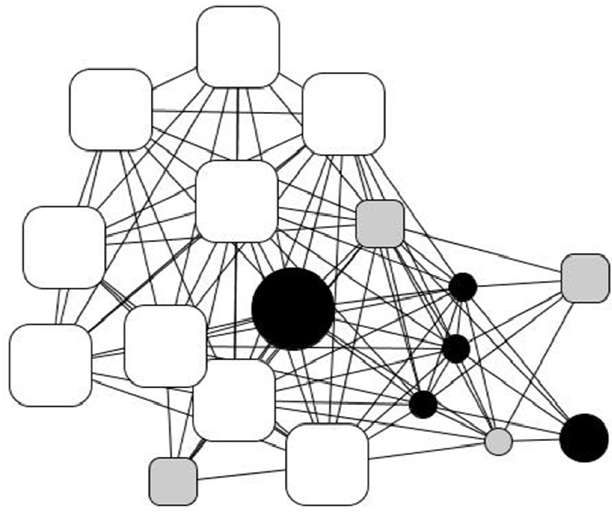
Figure 3. Kike’s personal network. Node color indicates the type of relationship: family members (black), friends and acquaintances (gray), and professionals (white). Node size indicates ego’s perception of alter’s status: big size (ego perceives that “alter has a better socioeconomic situation than me”); average size (ego perceives that “alter has a similar situation as me”), and small size (ego perceives that “alter has a worse socioeconomic situation than me”). Node shape indicates the duration of the relationship: triangle (less than 1 year of relationship), square (between 1 and 5 years of relationship), rounded rectangle (more than 5 years) and circle (lifetime).